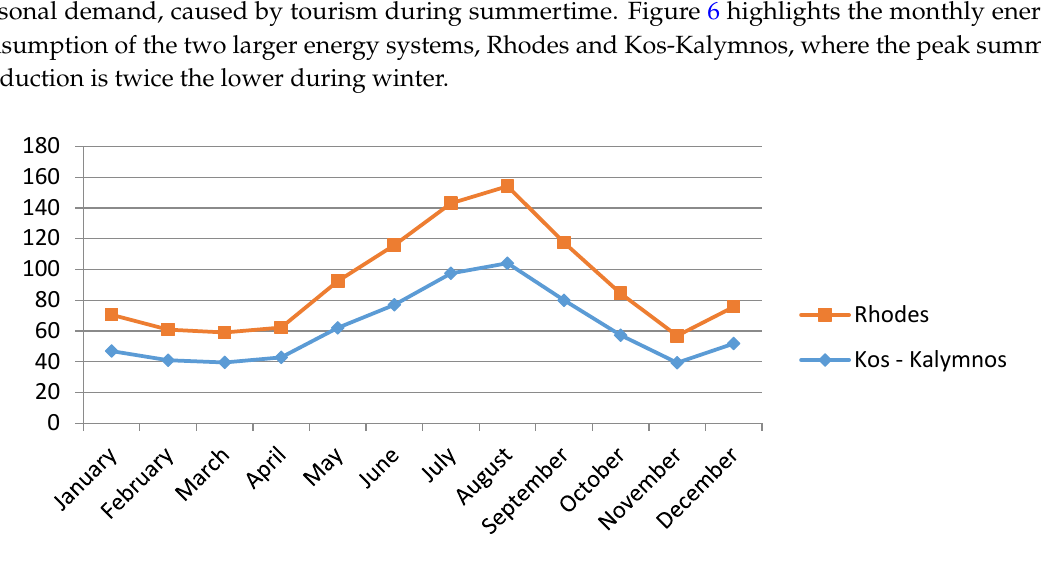
Figure 5. Annual energy consumption per municipality for the year 2012.